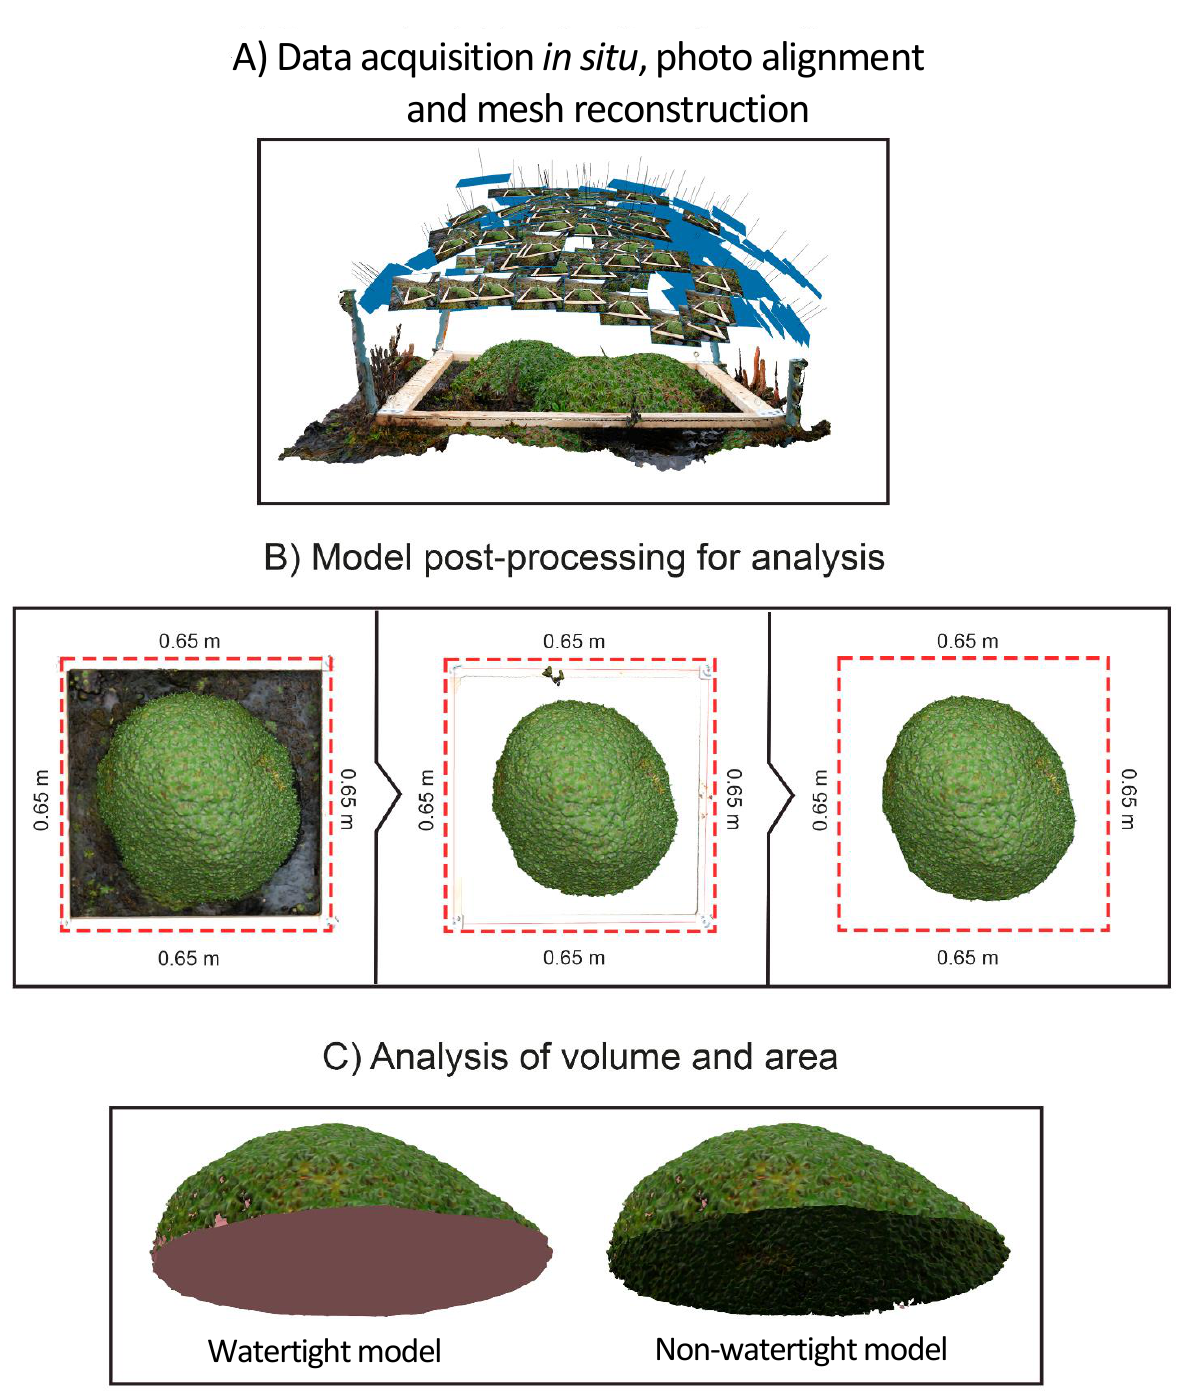
Figure 1. Outline of processing and analysis stages for 3D plant modelling. RESULTS The modelling process used between 121 and 261 images for each cushion, producing high precision 3D models using an average of 50000 ± 17000 (mean ± SD) points per individual, with a mean resolution of 0.14 ± 0.008 mm px -1 , a spatial error of 1.6 ± 0.1 mm, and a reprojection error of 0.73 ± 0.04 px.